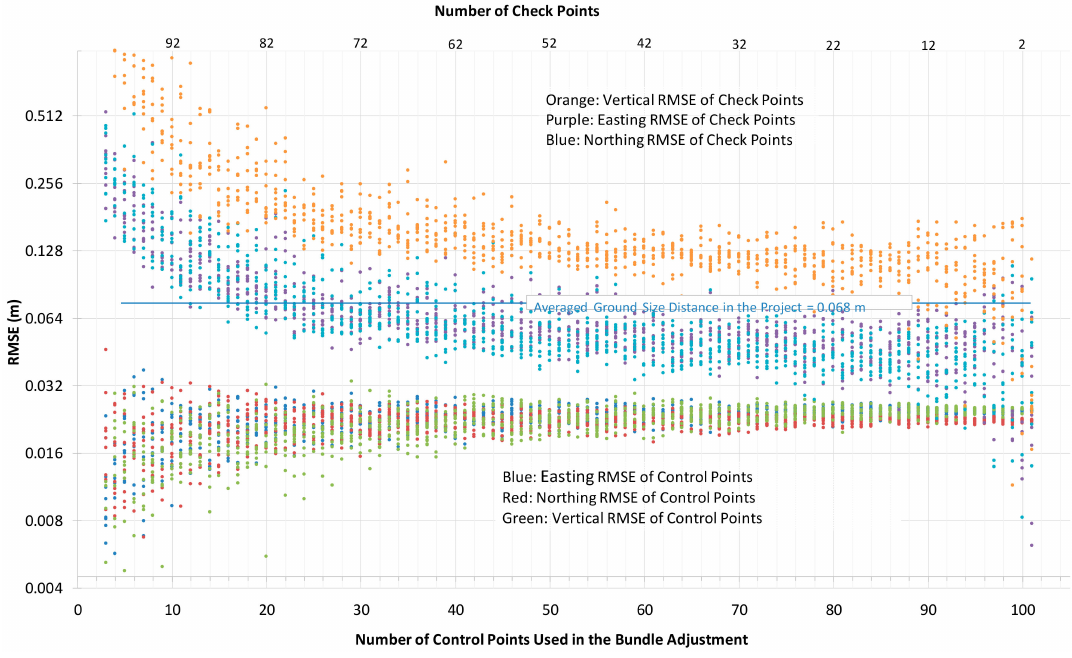
Figure 6. RMSE in control and check points, considering axes